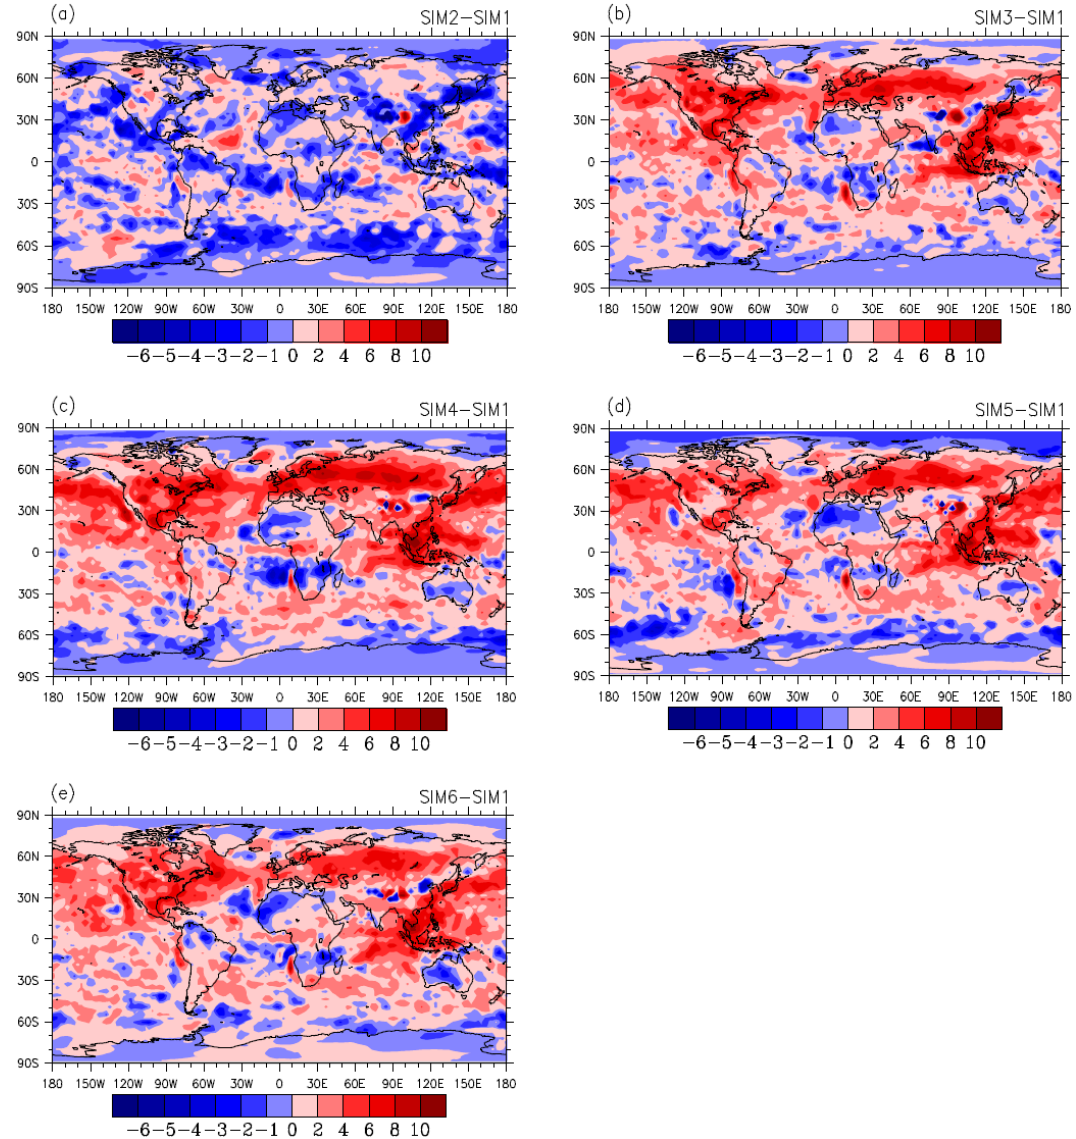
Figure 7. Global distributions of difference in simulated annual mean aerosol net effect (units: Wm − 2 ). (a) SIM2–SIM1, (b) SIM3–SIM1, (c) SIM4–SIM1, (d) SIM5–SIM1, and (e)